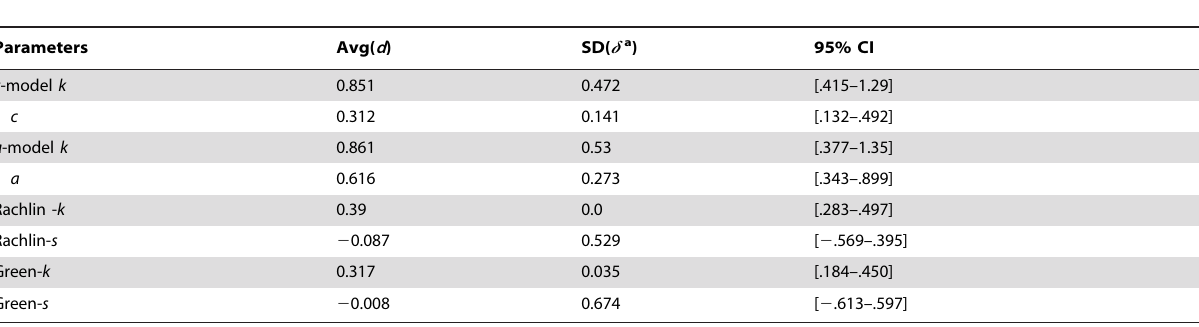
Table 11. Meta-Analysis of Effect Size (Cohen’s d) When Testing Magnitude